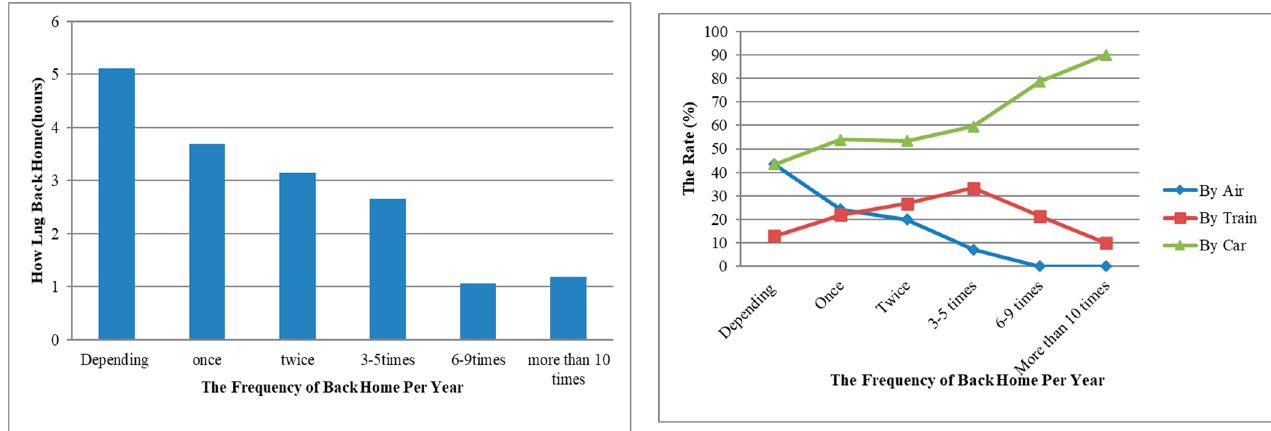
Figure 5. Relationship between the frequency of returning home and the mode of transportation. There are 15 villages with median values ranging from 2 to 3 (Figure 6). These villages can be divided into two categories. The first category includes seven villages. The box plots of these villages are short and their medians are roughly in the centers of the boxes, indicating that the household hollowing of these villages is generally low, concentrated, and symmetrical. The second category consists of eight villages. The box plots of these villages are long, that is, the household hollowing variations are significant. Furthermore, the median values of these villages are generally low and the upper quartile and maxi- mum values are generally higher, indicating that the values are more dispersed when the household hollowing value is higher than the median. There are four villages whose median values are between 3 and 4. Of these villages, two have short box plots and their upper quartile data are approximately 4, showing that their household hollowing is relatively low. There is one village with a short box plot and a median value close to 4, demonstrating that its household hollowing is relatively high and concentrated. There is also one village with a long box plot, with a median value that